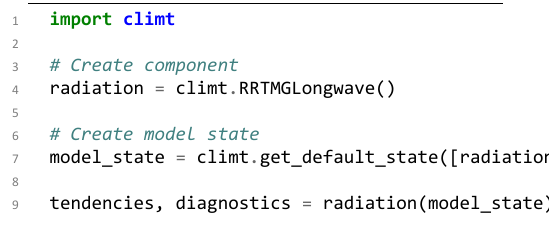
Figure 1. A Python script which calculates the heating tendencies and associated diagnostics from a longwave radiative transfer com- ponent. See the text for a detailed